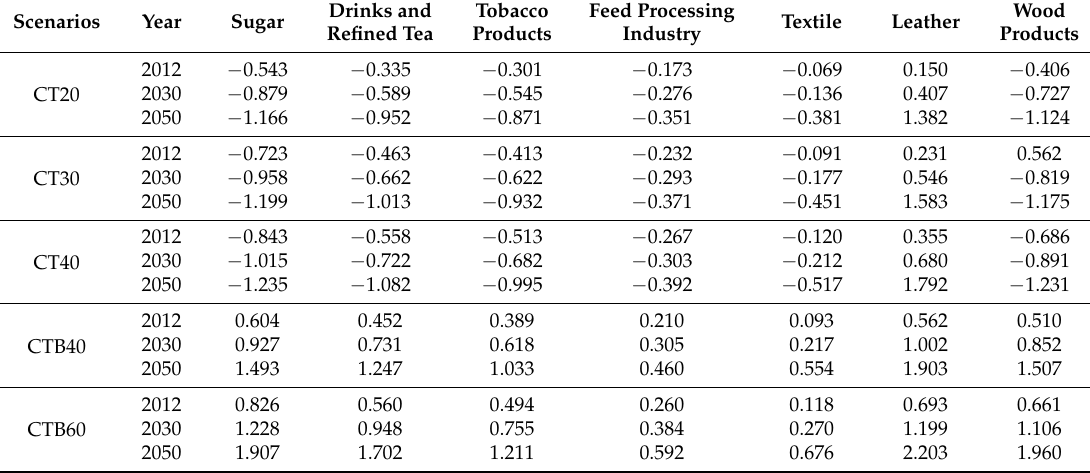
Table 13. The changes in households’ income in agriculture-related sectors under different scenarios compared with the BAU scenario (%) (from sugar to wood